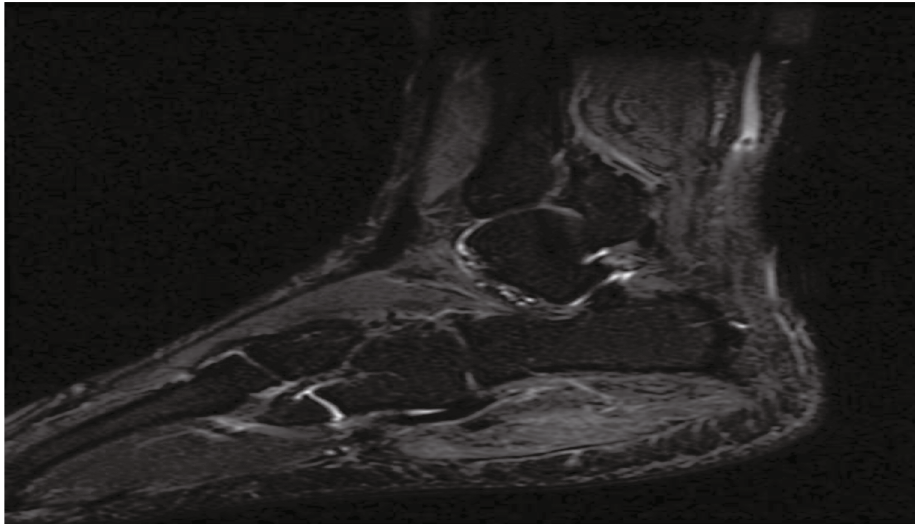
Figure 3: Short T1 inverse recovery (STIR) showing enlargement of the muscle with di ff use heterogeneous increase in signal intensity, with no drop of signal on fat-saturated image and normal signal intensity of the bone.